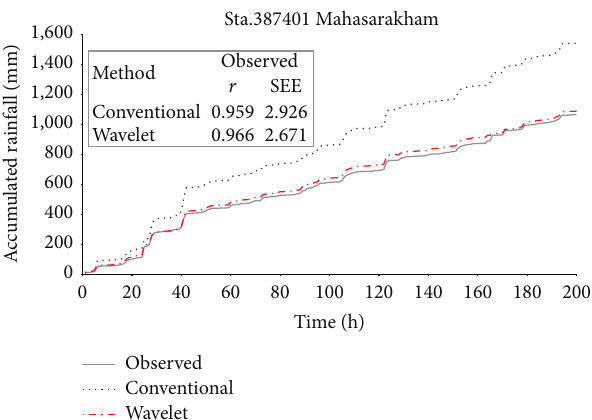
Figure 12: Time series plot of mean observed rainfall at sta.405201 Roiet compared with conventional and wavelet filters technique.